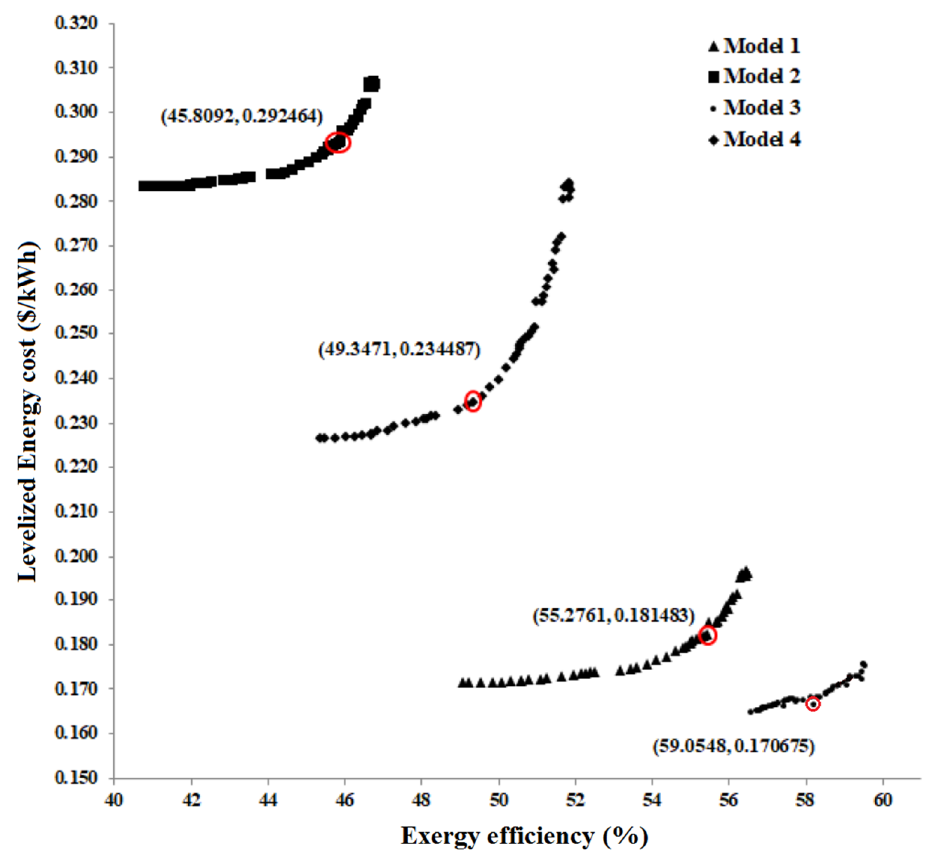
Figure 6. The Pareto frontier solutions obtained by performing the optimization procedure for four predefined models with fixed mixing ratio of 0.5 for Pentane/R24fa working fluids.